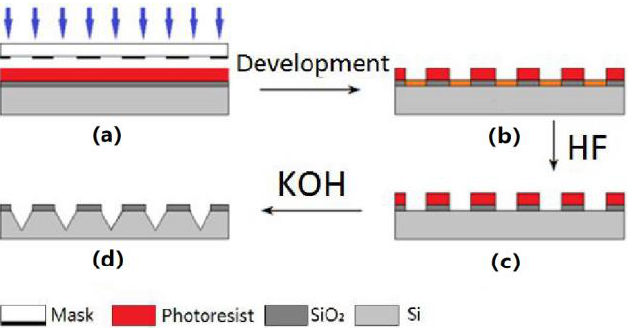
Figure 2. Manufacturing process of MNA tip array. ( a ) Exposure. ( b ) Developing. ( c ) Silica etching. ( d ) Silicon etching.